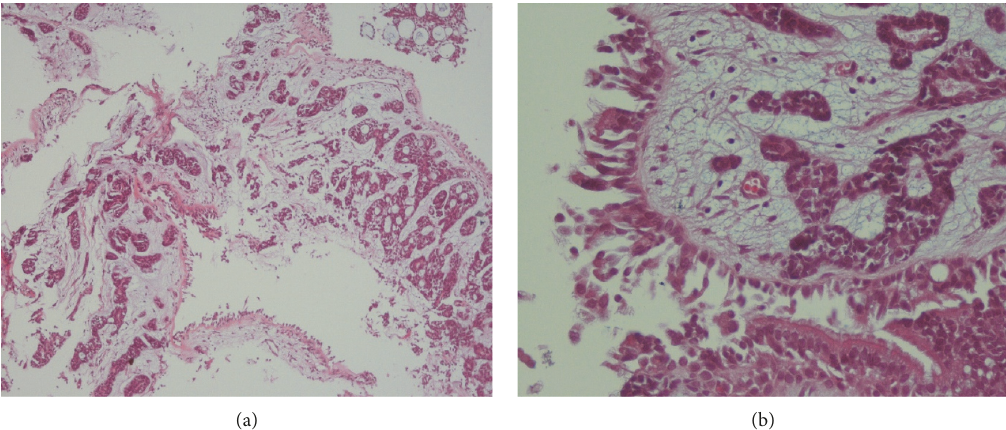
Figure 3: Endobronchial biopsy. (a) Bronchial mucosa contains infiltrative neoplastic lesions with tubular and cribriform patterns (H&E stain, × 100). (b) Tubular and cribriform structures of the neoplasm (H&E stain, ×